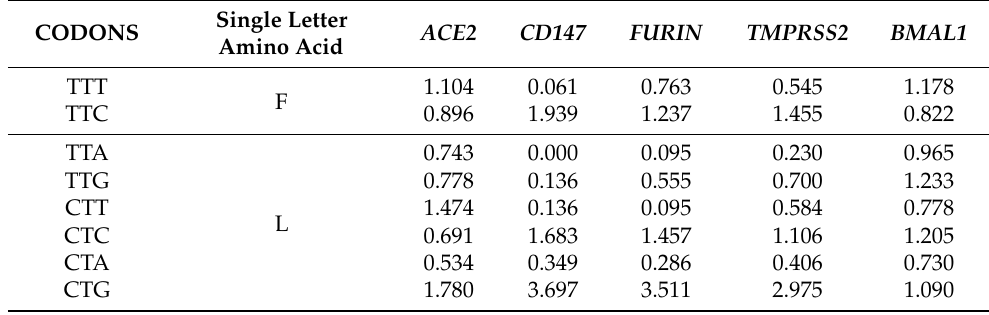
Table 1. Average RSCU values of ACE2 , CD147 , FURIN , TMPRSS2 , and BMAL1 genes.